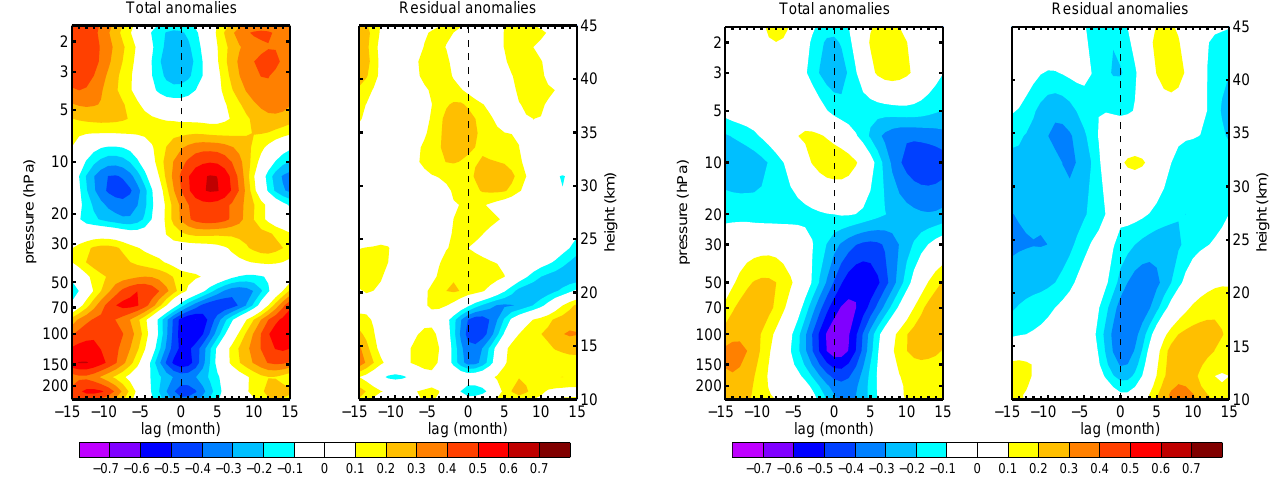
Fig. 7. As in Fig. 6 but using water vapour from the ERA-I reanal- Fig. 7. As in Figure 6 but using water vapour from the ERA-I reanalysis for the period 1979–2010. Absolute ysis for the period 1979–2010. Absolute correlation values greater correlationvaluesgreaterthan0.3arestatisticallysignificantabovethe99%level(seetext). than 0.3 are statistically significant above the 99% level (see